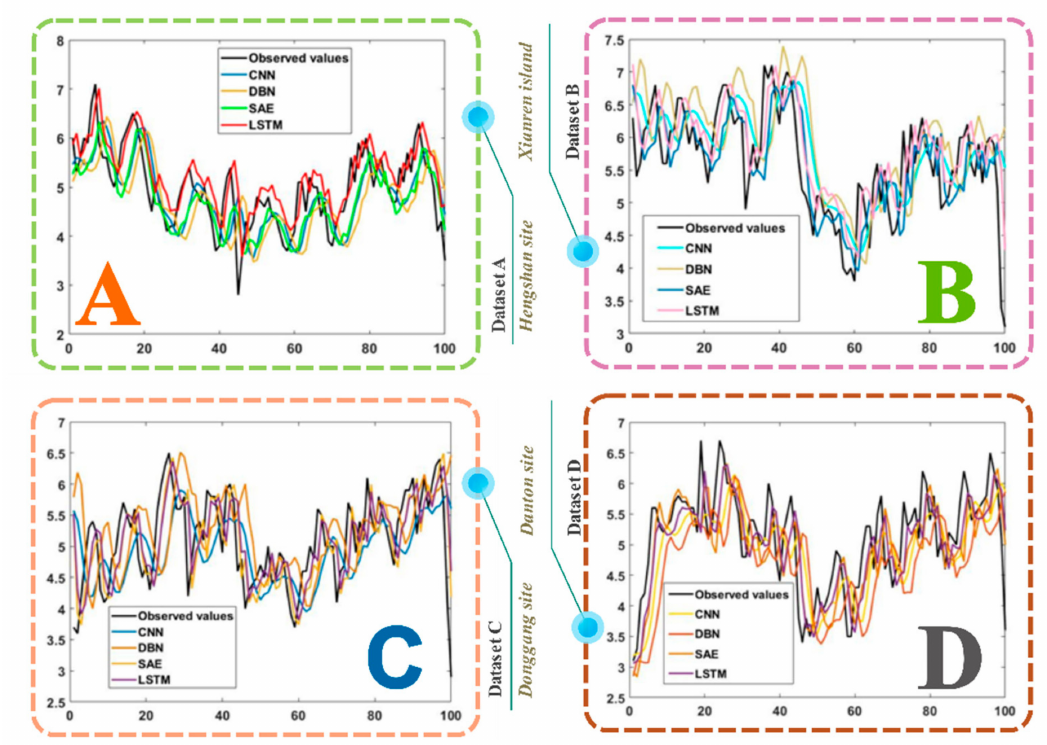
Figure 8. Forecasting results of the four deep learning